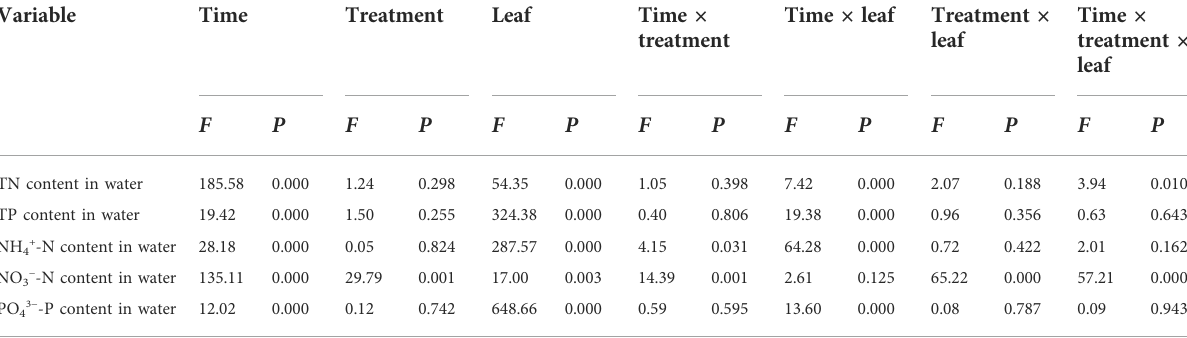
TABLE 4 Results of repeated measures analysis of variance on nutrient content in overlying water under conditions of decomposition time, water treatment, and interaction in the Three Gorges Reservoir in China. Variable